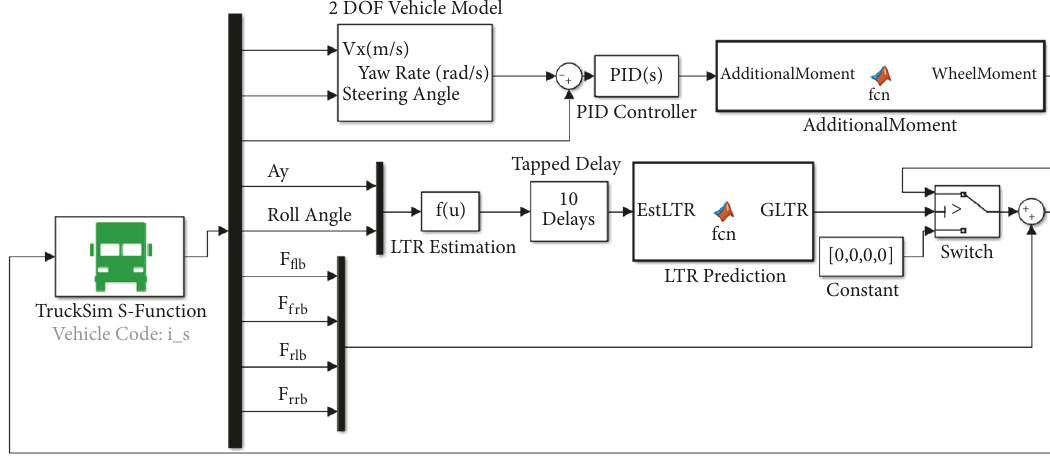
Figure 13: GLTR control system using PID controller.